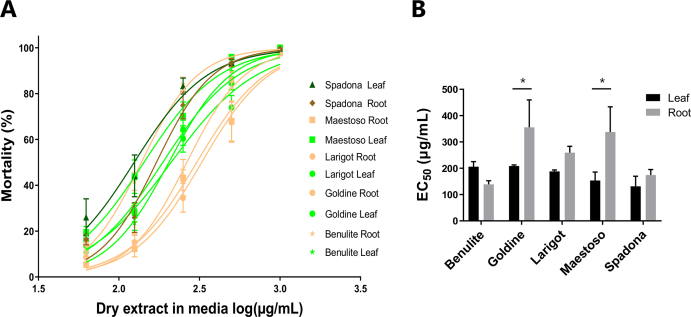
Dose-dependent anti-parasitic effects of chicory extracts A) Concentration-response curve of chicory extracts on mortality of Ascaris suum third stage larvae. The inhibition is calculated relative to the control (1% DMSO, corresponding to the amount of DMSO in the samples). The means are presented with S.E.M., based on three different extractions, each tested in triplicate in the A. suum assay. Colors are used to demonstrate the trend of differences between the leaf extracts (green lines and markers) and the root extracts (orange lines and markers). B) EC50 values of leaf and root extracts from different cultivars. Three independent extractions were made and the EC50 calculated for each (mean of N = 3 with S.E.M. is presented). The effects of tissue type and cultivar were assessed by two-way ANOVA. *P < 0.05 by Fisher's L.S.D. (For interpretation of the references to color in this figure legend, the reader is referred to the Web version of this article.)